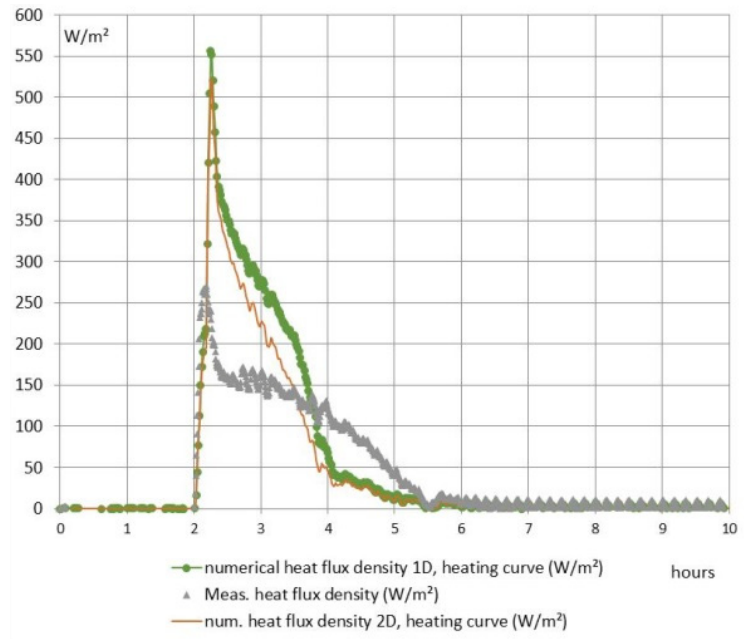
Figure 9. Comparison between 1D and 2D results for heat density to surface container. Cooling case—heating heat capacity curve.